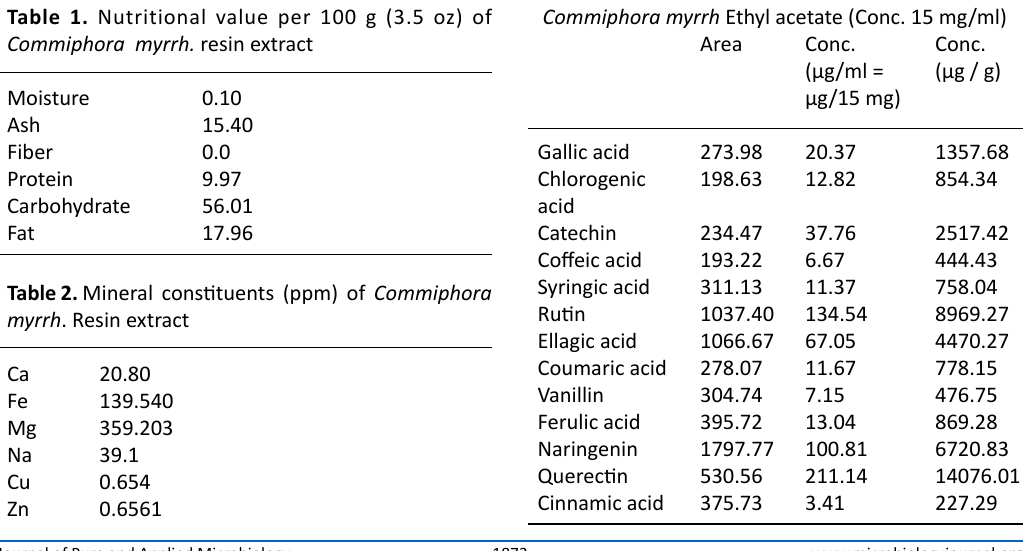
Table 1. Nutritional value per 100 g (3.5 oz) of